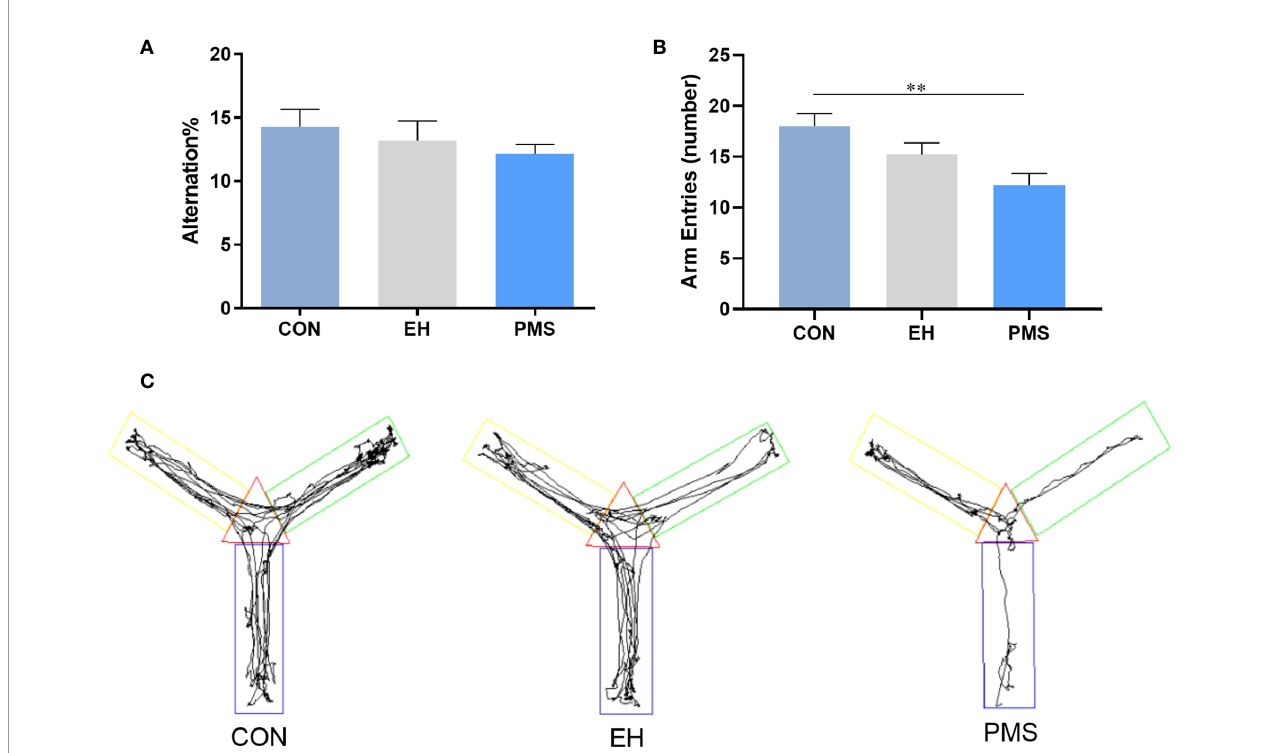
FIGURE 4 | Comparative effects of two different separation modes in the PMS and EH group on spontaneous Y-maze alternation performance of rats [ (A) : alternation %, (B) : number of arm entries]. Each bar represents the mean ± SEM (n= 11 rats per group). Representative diagrams of the pathways in the Y-maze test from each group, (C) showed the rats ’ mobile trajectory Figs in CON, EH and PMS group. **p < 0.01.